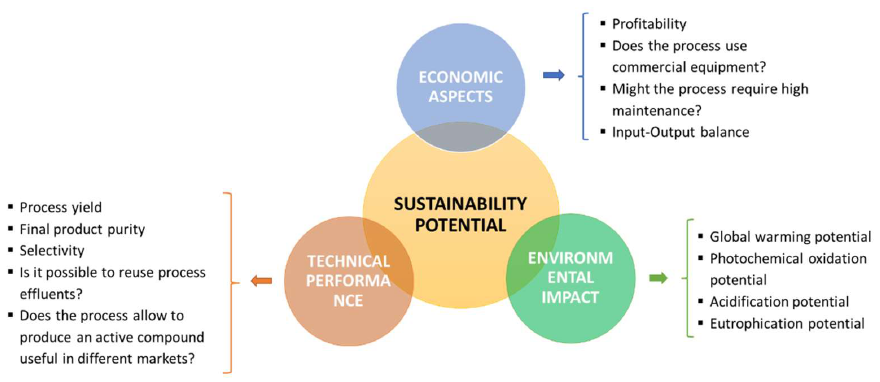
Figure 1. Set of categories and components defined as a result of the DELPHI Method inspired